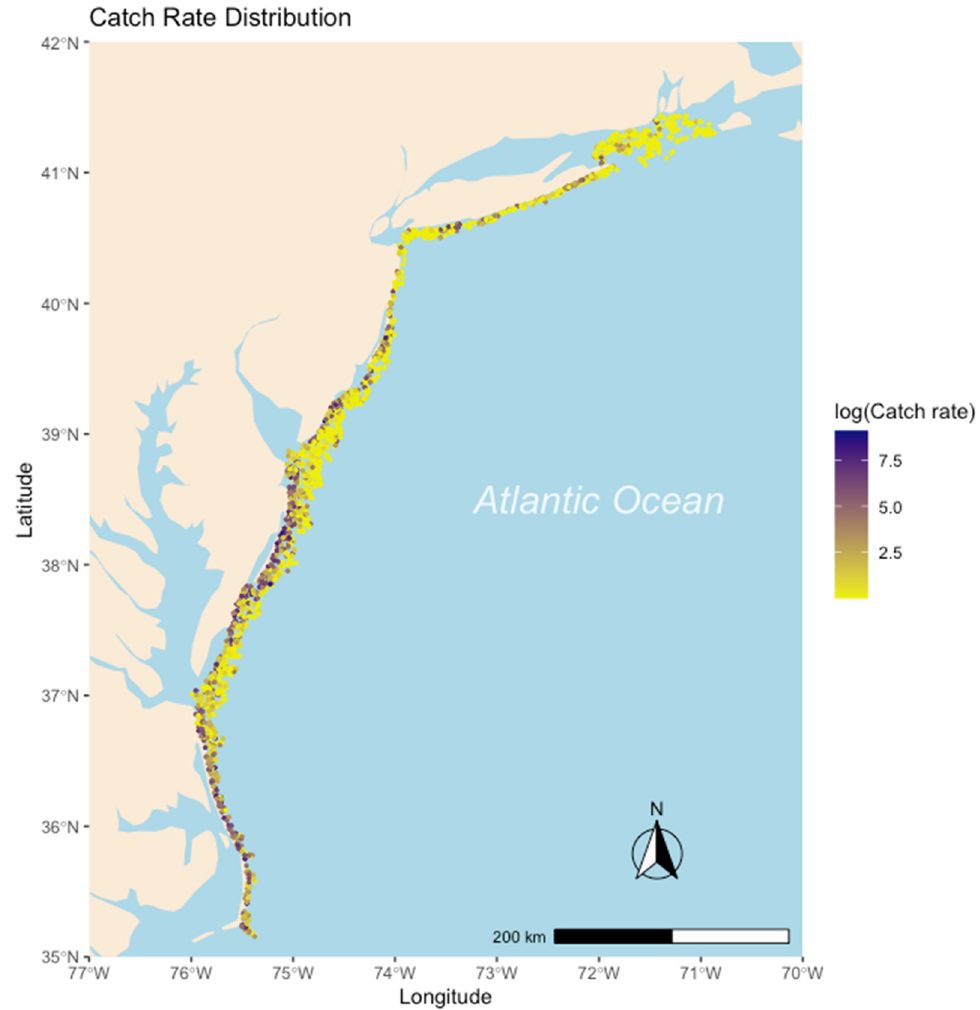
Figure 1. Catch rate (log transformed) distribution map for NEAMAP weakfish survey data. Point color is proportional to the value of log transformed catch rate.